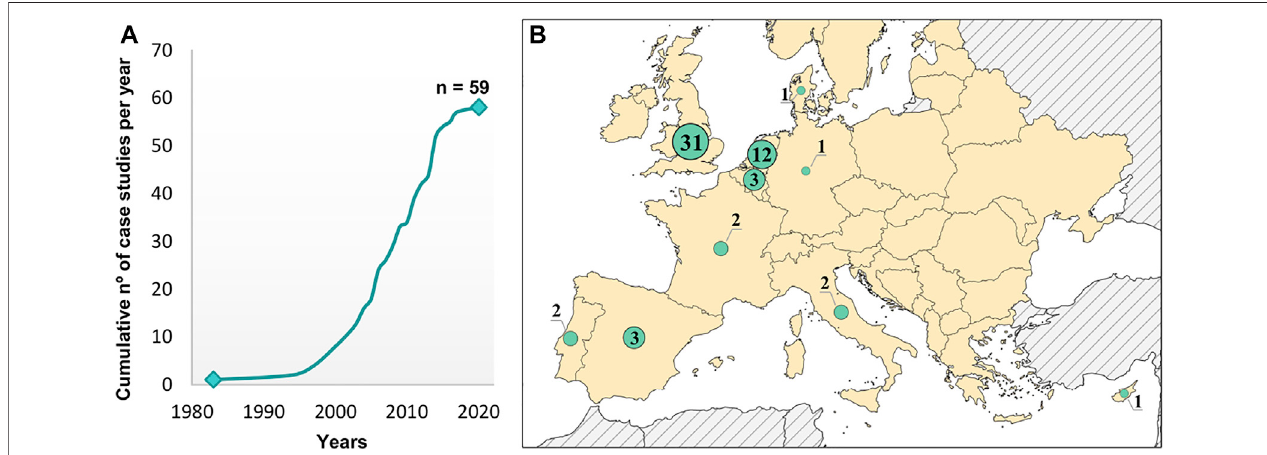
FIGURE1| Temporal andspatial distribution ofNbScasestudies inEurope,shown by (A) thecumulativenumber ofprojectsimplementedperyear and (B) amap of the European continent.